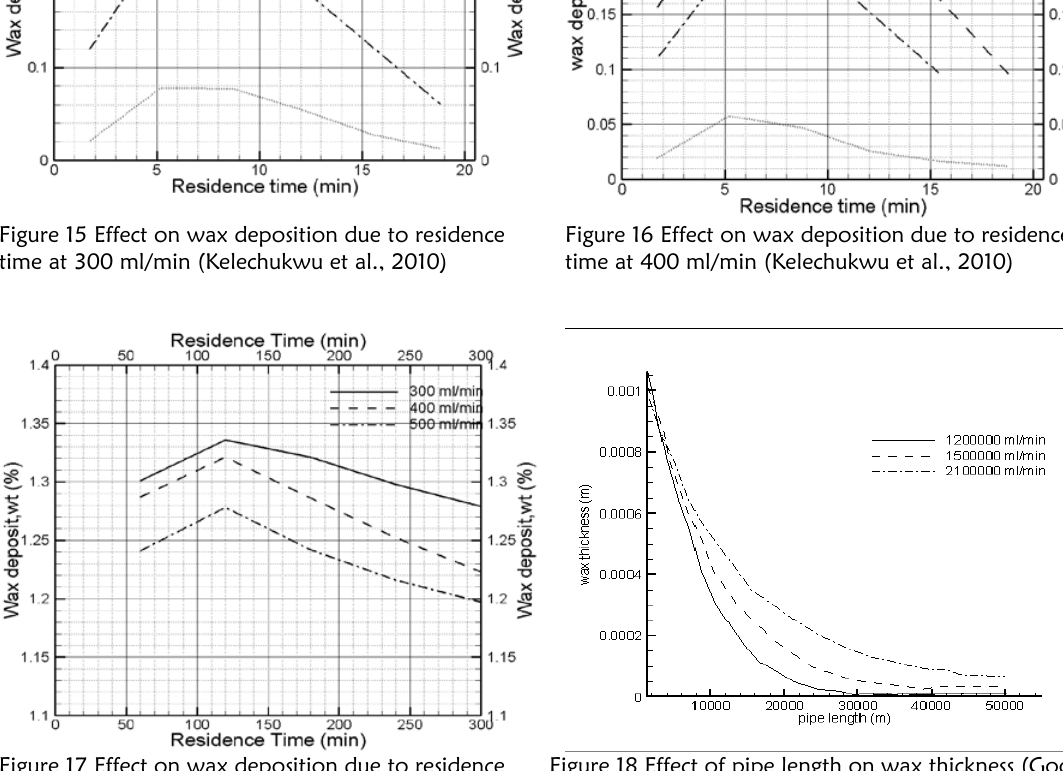
Figure 17 Effect on wax deposition due to residence time (Mahto and Kumar, 2013)